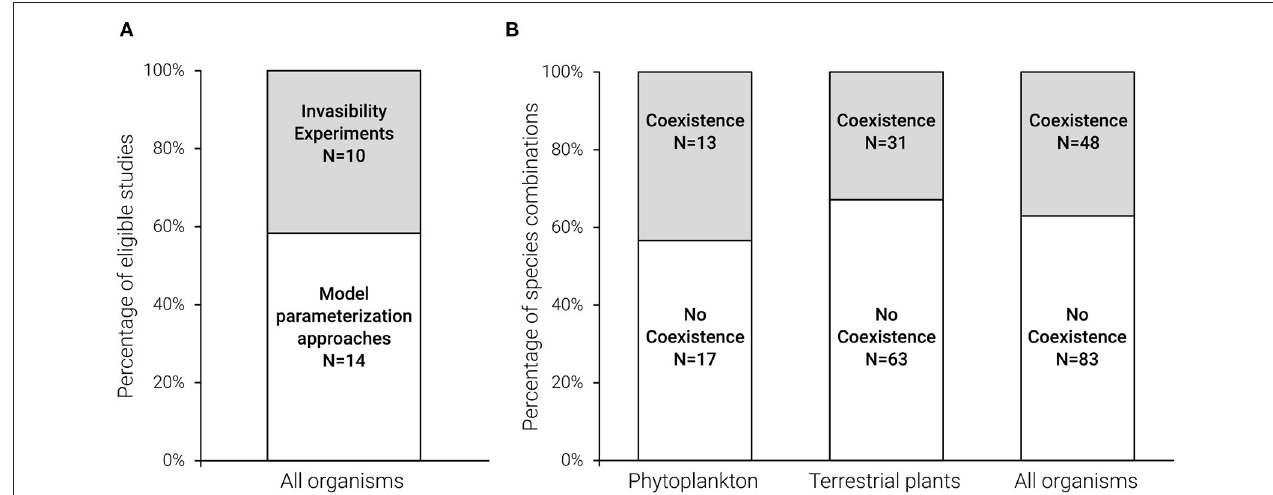
FIGURE 4 | Assessment of coexistence prevalence, illustrating the limited evidence for coexistence in nature. Mutual invasibility tests are methods that are based on the theoretical distinction between stable coexisting and transient co-occurring species, and as such, can be exploited to assess coexistence prevalence in nature. Adequate tests of the mutual invasibility criterion can be conducted either directly by invasibility experiments or indirectly by model parameterization studies ( Figure 3B ). Our literature survey identified only a few eligible studies based on invasibility tests, and the division of studies between the two methods was similar (A) . The two best explored study systems with respect to invasibility tests—phytoplankton and plants (22 and 73% of the 140 tested species combinations, respectively)—provided low ( < 44%) support for coexistence (i.e., successful reciprocal invasibility; gray) in species combinations co-occurring in nature (B) . Note that the species combinations that do not co-occur in nature are not included in (B)